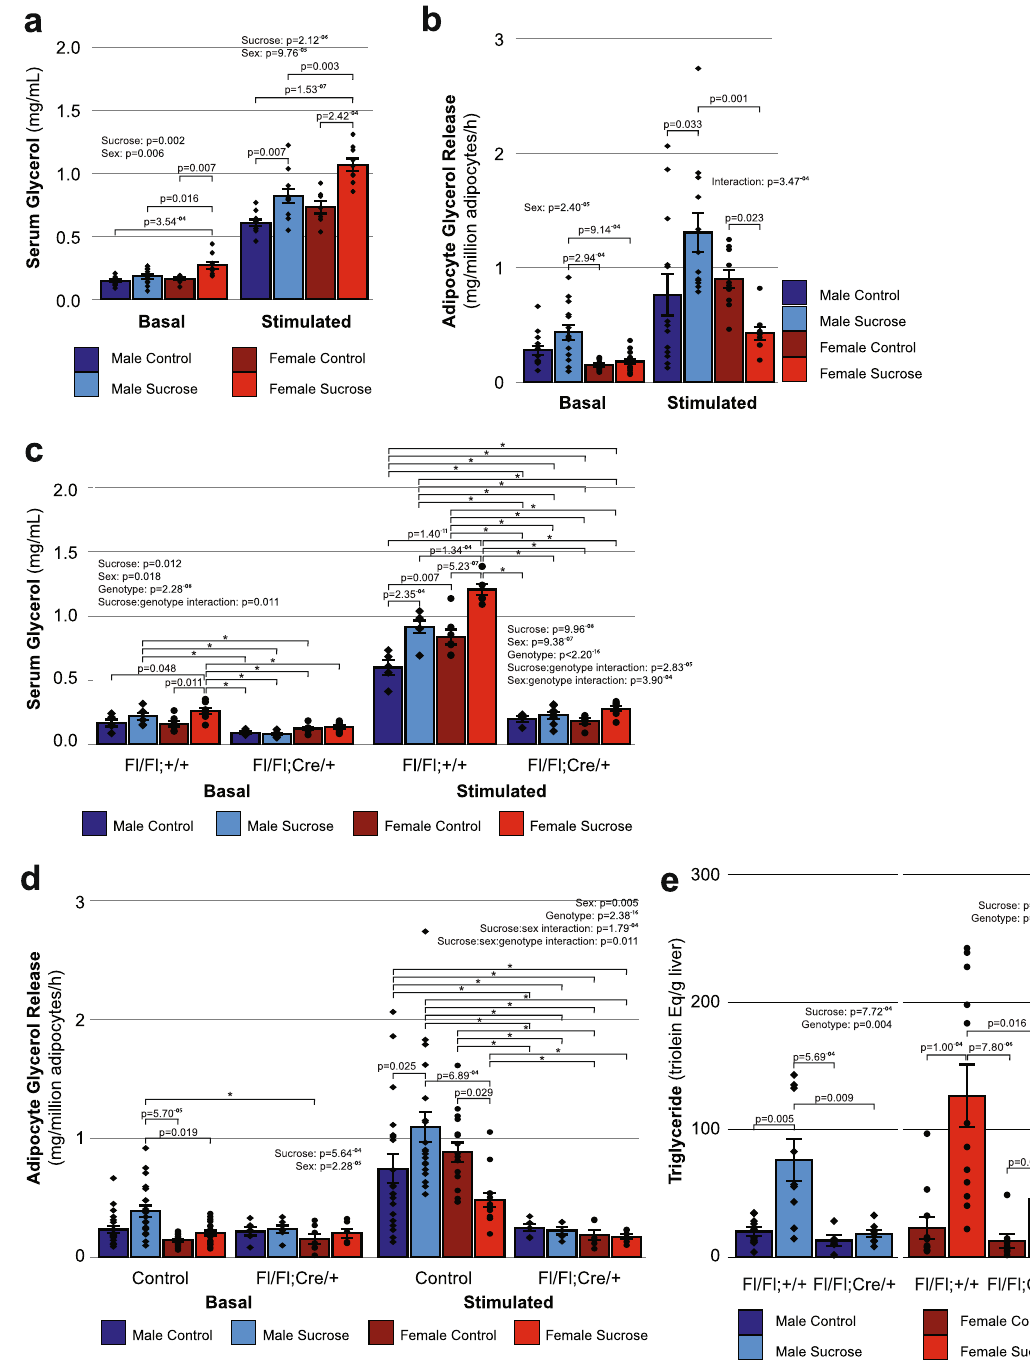
Fig. 3 | Limiting adipocyte lipolysis protects against sucrose-induced hepatic steatosis.a Serumglycerolappearanceinresponsetoinvivo β -ARstimulationwith isoproterenol was increased in both sexes following chronic liquid sucrose intake asdeterminedbytwo-wayANOVAwithpost-hocTukey ’ stest(MC: n =11,MS: n =11, FC: n =7, FS: n =9; see fi gure for p -values). b Sucrose intake potentiated stimulation-induced glycerol release from adipocytes from male mice but atte- nuated stimulated glycerol release in adipocytes from female mice as determined by two-way ANOVA with post hoc Tukey ’ s test (log-transformed basal values) and Scheirer – Ray – Hare test and post hoc Dunn analysis with Benjamini and Hochberg correction for multiple comparisons (stimulated values; basal/stimulated MC: n =14/13, MS: n =14/12, FC: n =11/10, FS: n =13/9; see fi gure for p -values). c , d Comparedtomicewithcontrolgenotypes(serumbasal/stimulatedMC: n =5/5, MS: n =6/6, FC: n =7/7, FS: n =8/8; adipocytes basal/stimulated MC: n =21/20, MS: